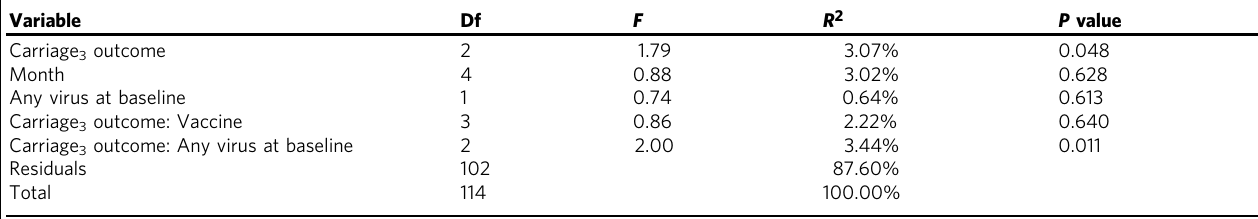
Table 1 Associations between baseline nasal microbiota and carriage 3 outcome Variable